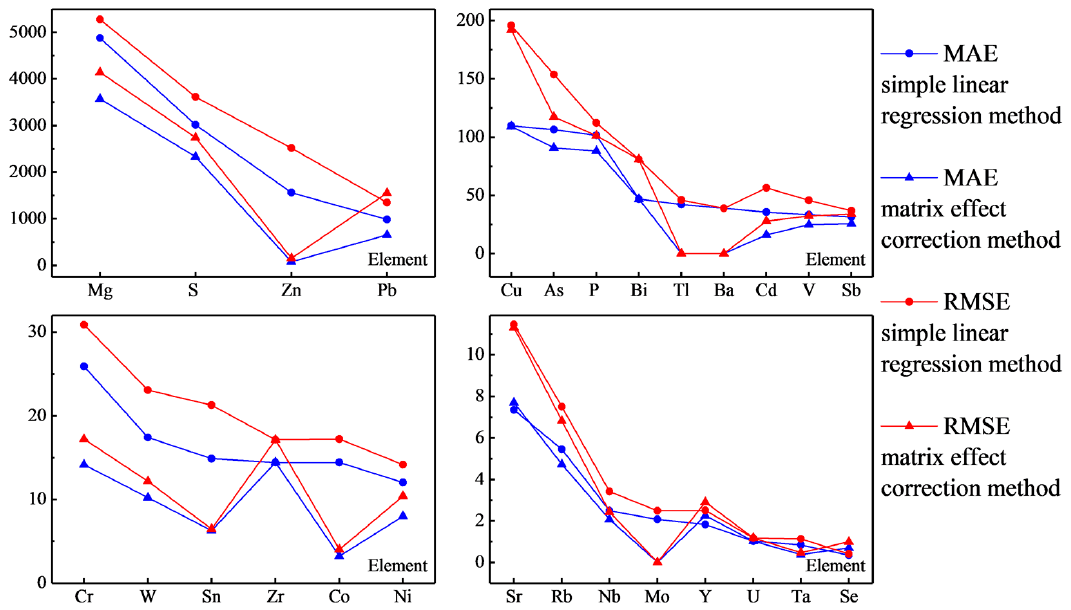
Figure 5. The MAE and RMSE values for the correction results of the new and SLR methods.